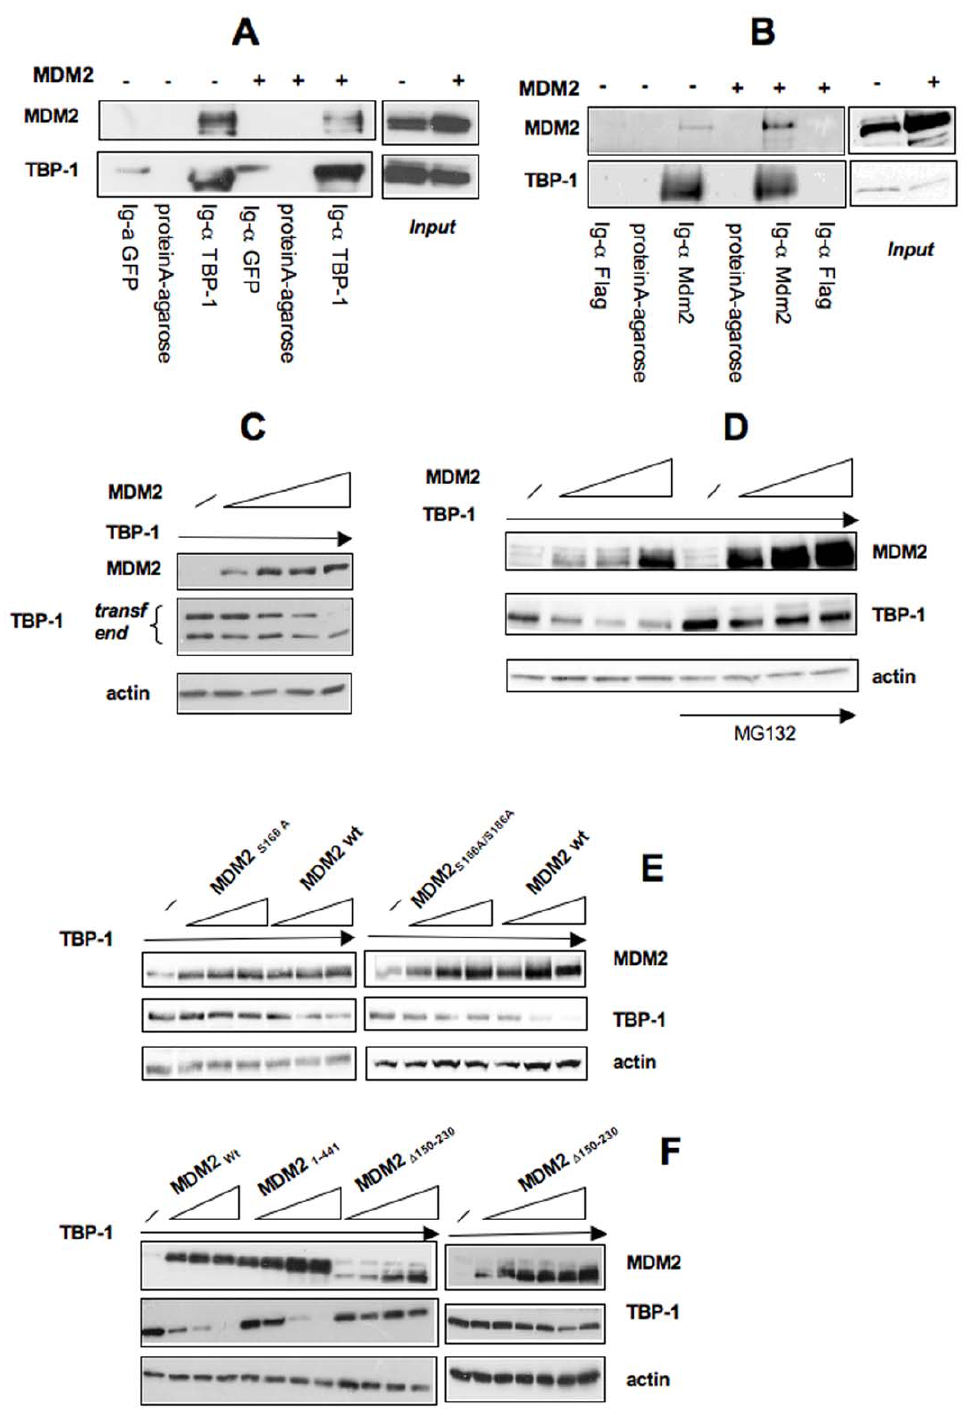
Figure 7. TBP-1 is a downstream target of MDM2 activation. A: U2OS cells were either transfected (lanes + ) or untransfected (lanes 2 ) with the MDM2 expression plasmid. 24 hrs after transfection cell extract was prepared and subjected either to immunoprecipitation with anti-TBP-1 antibody where indicated or, with anti-GFP antibody as negative control. Cell extracts were also incubated with protein A-agarose as control, where indicated. Immunoprecipitated extracts were analyzed by Western Blot with anti-MDM2 or anti-TBP-1 antibody. Aliquots of cell extracts were analyzed by Western Blot before immunoprecipitation ( input ). B: U2OS cells were either transfected (lanes + ) or untransfected (lanes 2 ) with the MDM2 expression plasmid. 24 hrs after transfection cell extract was prepared and subjected either to immunoprecipitation with anti-MDM2 antibody where indicated or, with anti-Flag antibody as negative control. Cell extracts were also incubated with protein A-agarose as control, where indicated. Immunoprecipitated extracts were analyzed by Western Blot with anti-MDM2 or anti-TBP-1 antibody. Aliquots of cell extracts were analyzed by Western Blot before immunoprecpitation ( input ). C: U2OS cells were transfected with TBP-1 expression plasmid and increasing amounts of MDM2 expression plasmid. After 24 hrs, cells were lysed and whole cell extracts probed with anti-TBP-1, anti-MDM2, and anti-actin, for loading control. D: U2OS cells were transfected with TBP-1 expression plasmid and increasing amounts of MDM2 expression plasmid. After 24 hrs cells were treated